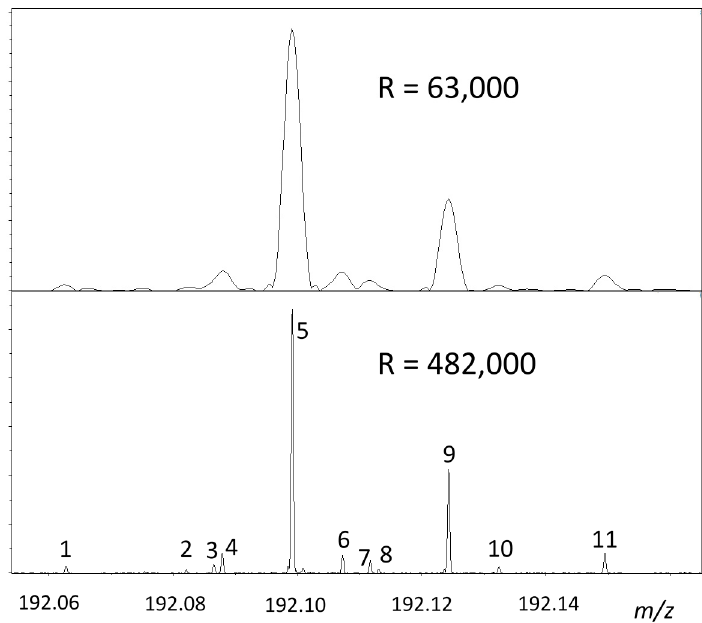
Figure 3. Comparison of information content obtained for LDI generated ions with the nominal mass of m/z 192 at two different resolutions (63,000 upper ; 482,000 lower spectrum). The list of ions corresponding to the labeled peaks is collected in Table 1.